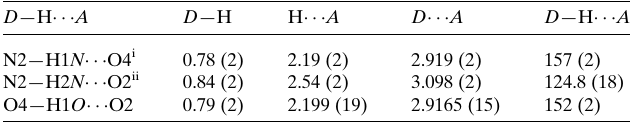
Table 3 Hydrogen-bond geometry (A˚ , (cid:3) ) for (III).